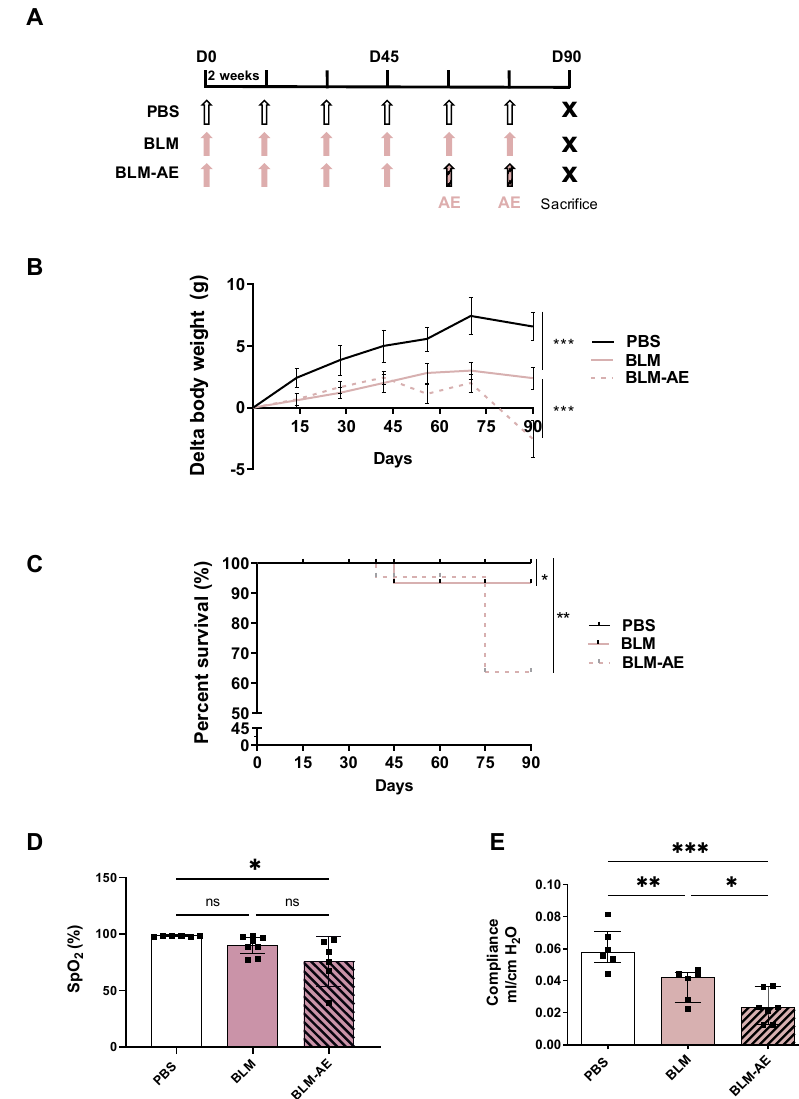
Figure 1. Experimental protocol, survival and weight curves. ( A ) Eight-week-old C57BL6/J male mice received six IT instillations (arrows) of bleomycin (BLM) at 0.8 IU/g or PBS every two weeks to form the BLM (pink arrow) and PBS groups (white arrow), respectively. In parallel, a group of mice received four IT instillations of 0.8 UI/g BLM, and then two IT instillations of BLM at 1.6 UI/g, thus forming the acute exacerbation group (BLM-AE, pink-hatched black arrow). Mice were sacrificed at day 90 (D90) for analyses. ( B ) Body-weight monitoring was established throughout the experiment, the difference in weight compared to the weight measured on day 0 (D0) before the IT instillations of PBS (n = 6, black line), BLM, (n = 6, dotted pink line) and BLM-AE (n = 7, pink line) groups are reported on a graph. A Friedman test followed by a Dunn’s multiple comparisons test was performed to estimate the difference in mice weight as compared to initial weight, *** p < 0.001. ( C ) Mouse survival was recorded every day until the end of the experimental design for the different groups (PBS, black line; BLM, dotted pink line; and BLM-AE, pink line) and plotted on a Kaplan–Meier curve. ( D ) Mouse peripheral oxygen saturation (SpO2) was measured by infrared pulse oximetry. ( E ) Lung compliance was measured by plethysmography. ( D , E ) Data were presented as a box plot representing the median ± interquartile range. Raw data were submitted to one-way ANOVA test followed by Newman–Keuls to compare each group (control PBS group (white bar), BLM group (pink bar) and BLM-AE group (pink hatched black bar)). ns: not significant, * p < 0.05, ** p < 0.01, *** p < 0.001, respectively.